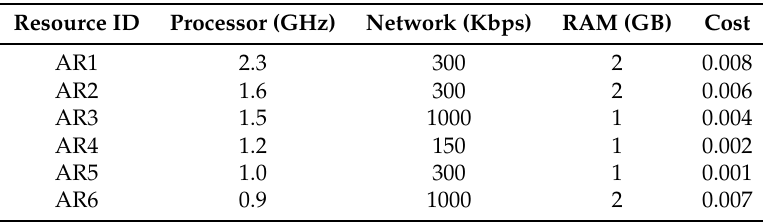
Table 2. Available resources of